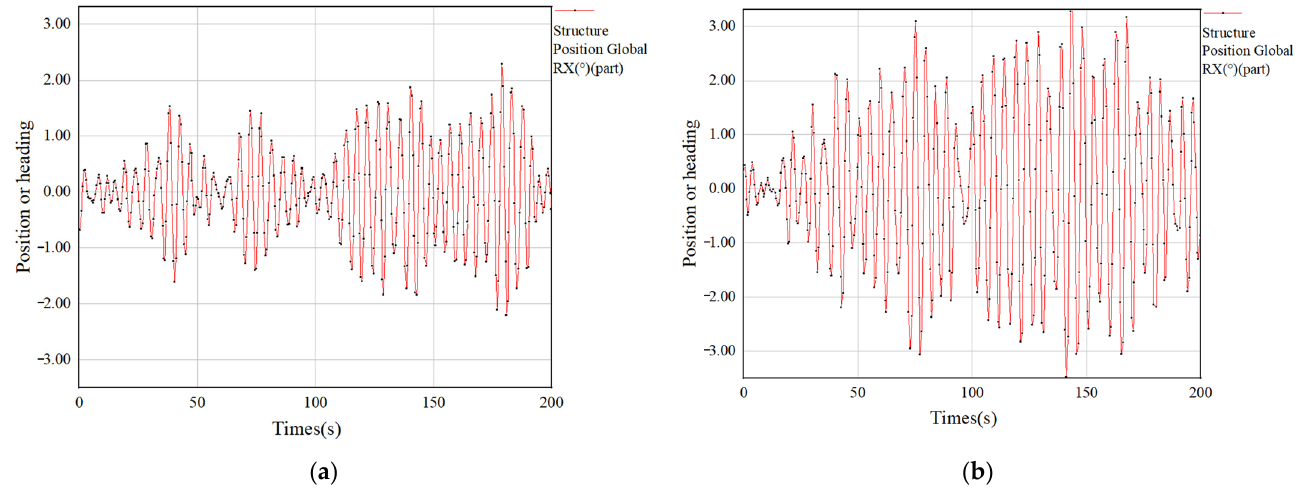
Figure 10. Dynamic response of buoy movement. ( a ) Transverse wave buoy, ( b ) Longitudinal wave buoy.